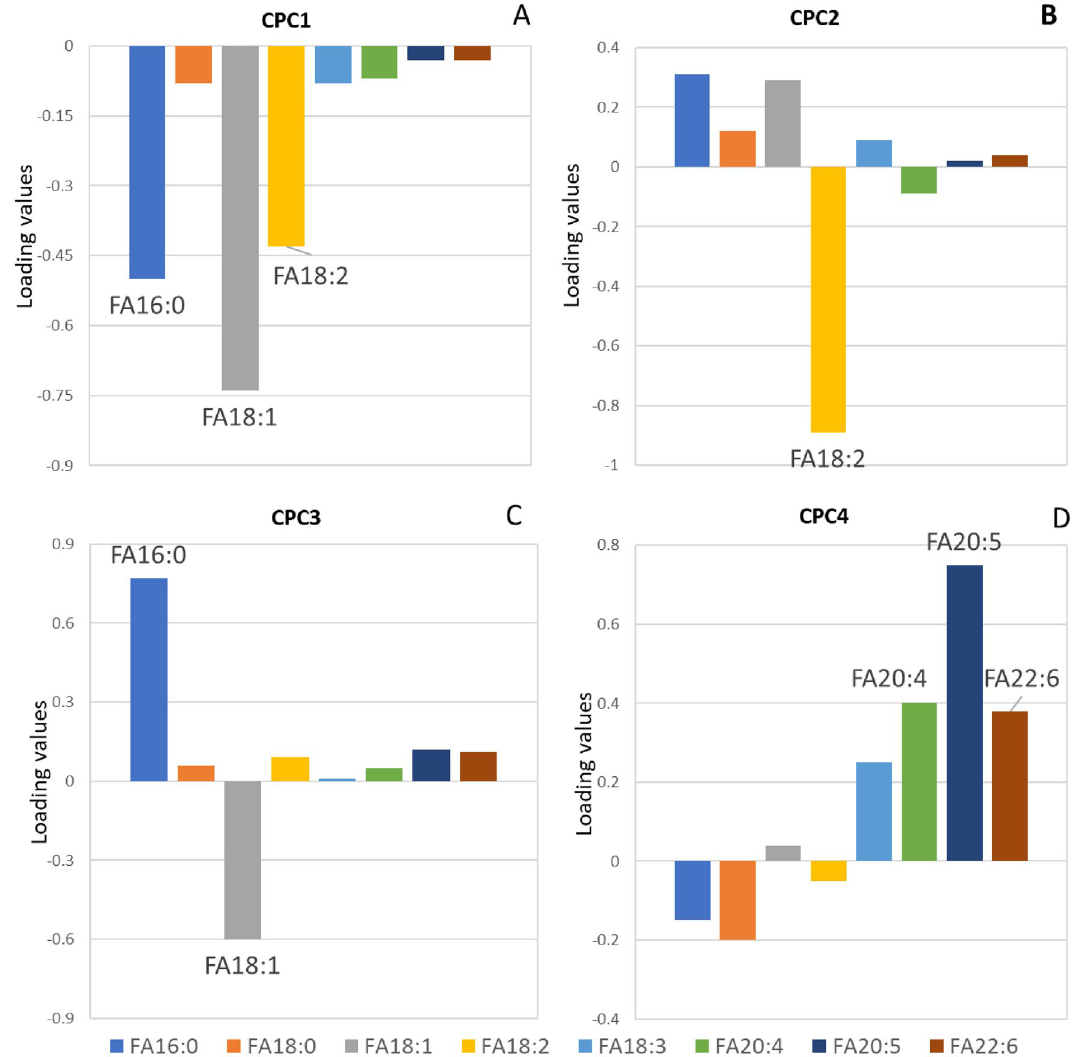
Figure 3. Histograms of CPCA results, including ( A ) CPC1, ( B ) CPC2, ( C ) CPC3, and ( D )